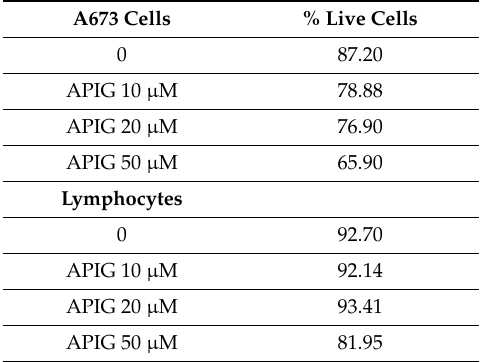
Table 2. Percentage of live cells expressed by the Viobility TM Fixable Dyes assay in A673 cells and normal lymphocytes. APIG: apigenin.